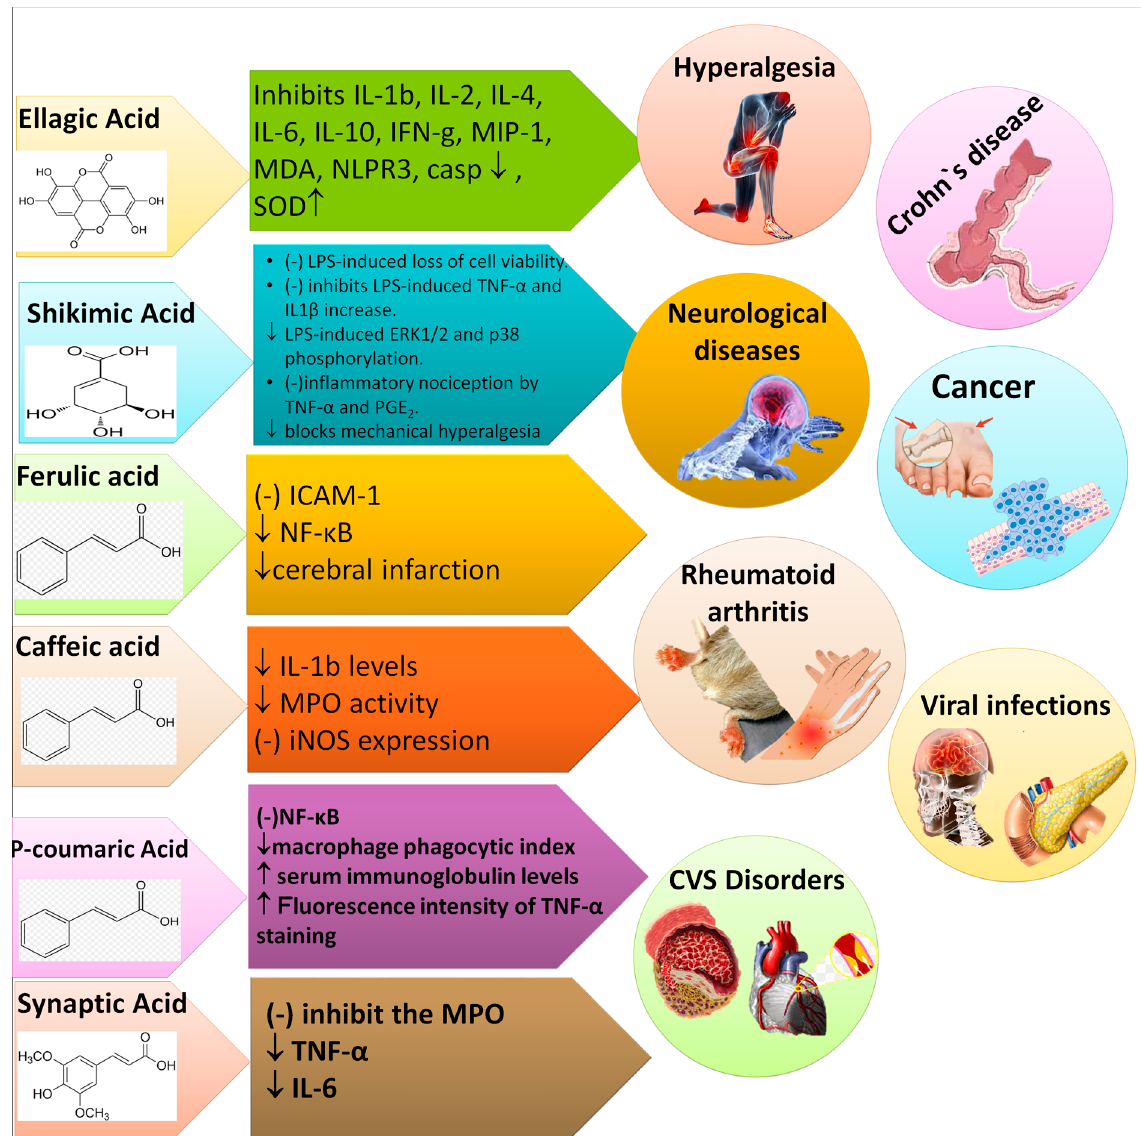
Figure 9. Phenolic acids and their target biomarkers in different inflammatory diseases. ↓ showed decreased, while ↑ showed increased.